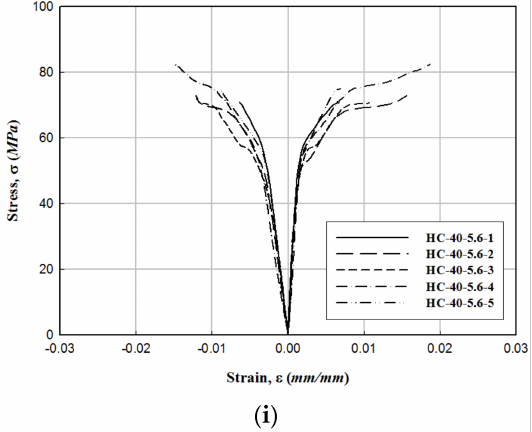
Figure 16. Stress–strain relationship of the hybrid − CFFT: ( a ) HC − 21 − 2.8, ( b ) HC − 21 − 4.2, ( c ) HC − 21 − 5.6, ( d ) HC − 30 − 2.8, ( e ) HC − 30 − 4.2, ( f ) HC − 30 − 5.6, ( g ) HC − 40 − 2.8, ( h ) HC − 40 − 4.2, and ( i ) HC − 40 − 5.6.